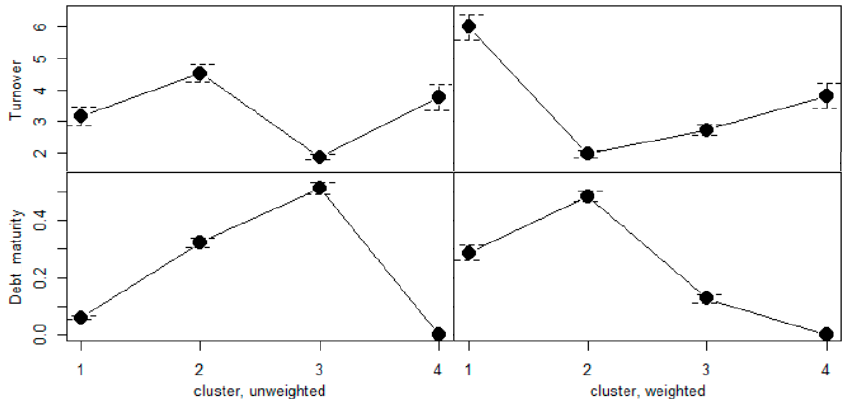
Figure 5. Confidence intervals for selected ratios in each unweighted ( left ) or weighted ( right ) cluster.